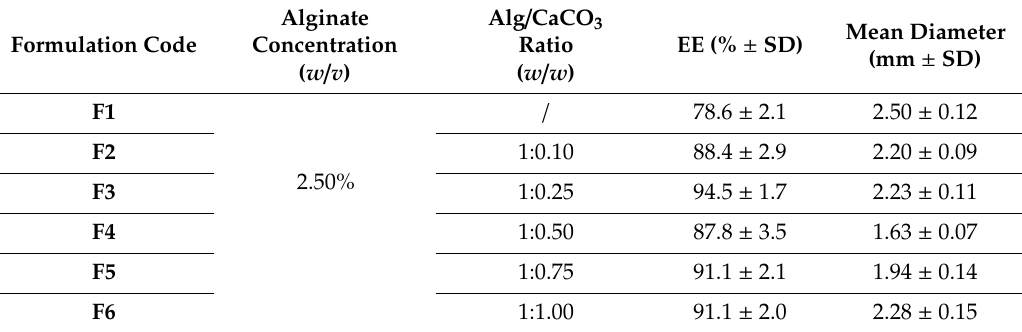
Table 1. Alginate / calcium carbonate floating beads loaded with prednisolone. Formulation code, alginate concentration, alginate / calcium carbonate ratio, encapsulation e ffi ciency (EE), and mean